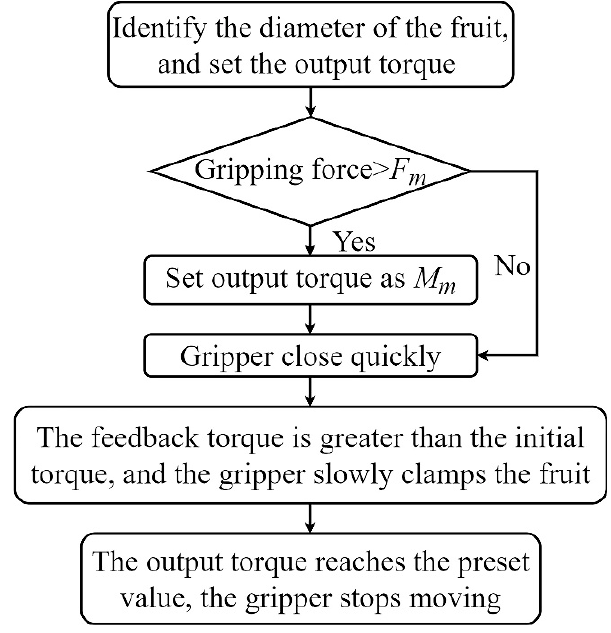
Figure 12. Gripper control method of constant-pressure feedback.